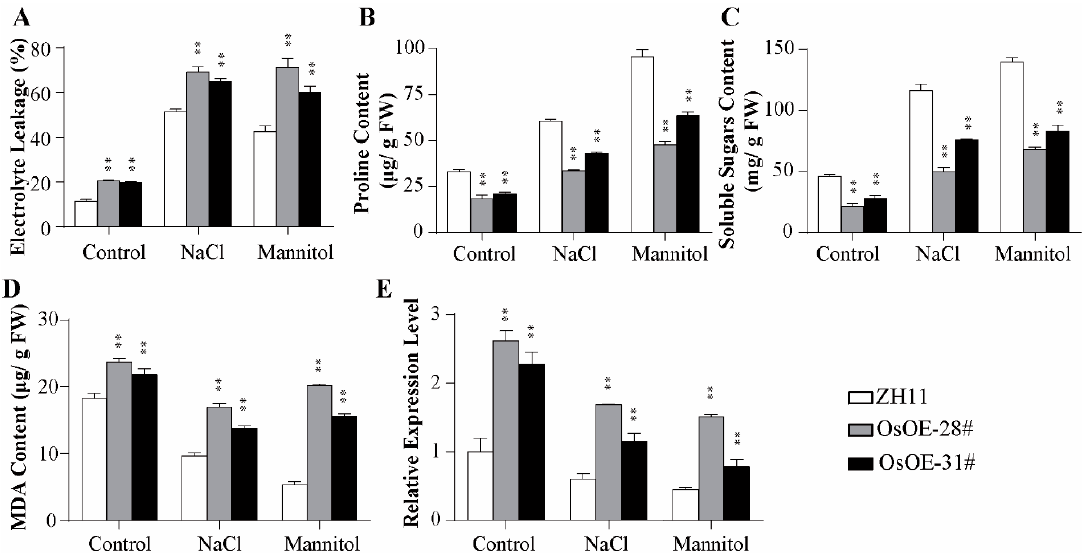
Figure 6. Oxidative damage of AcoMYB4 transgenic rice lines under osmotic stress. ( A ) Electrolyte leakage, ( B ) proline, ( C ) soluble sugars, and ( D ) MDA content as well as ( E ) OsMDA4 relative expression level in wild types and transgenic lines under salt or drought treatment for 2 days. The error bars indicate + SD ( n = 3 replicates). Asterisks indicate significant differences for the indicated comparisons based on Student’s t-test (** p < 0.01).